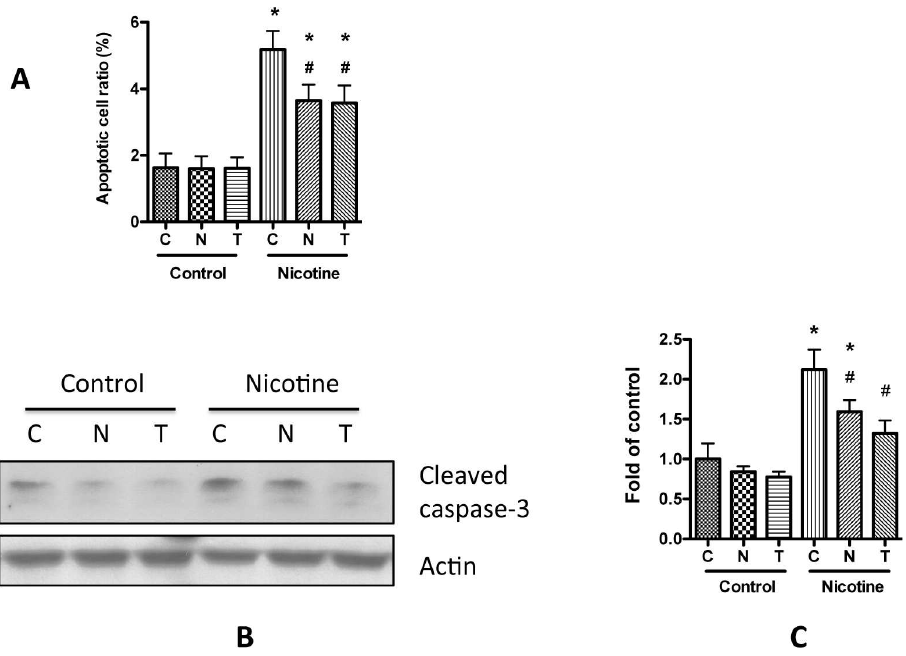
Fig 6. ROS scavengers attenuate nicotine-induced podocyte apoptosis. A . Differentiated human podocyteswere treated with nicotine(10 μ M) for 48 h in the presenceor absence of NAC (100 μ M) or TEMPO (10 μ M). Apoptotic cells were then determinedand countedby using Hoechst staining,as describedin Materials and Methods. Representative results (mean ± SD) were calculatedfrom 20 pictures of